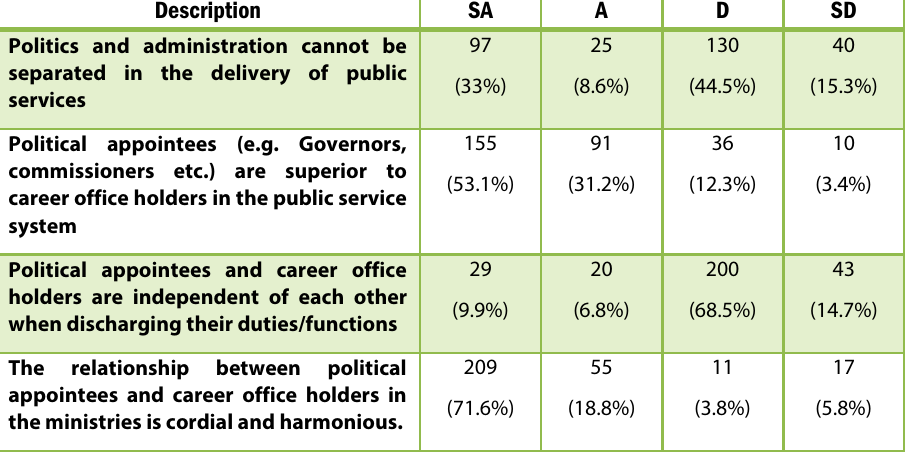
Table 1: Cases of Political-administration interface in Southwest Nigeria